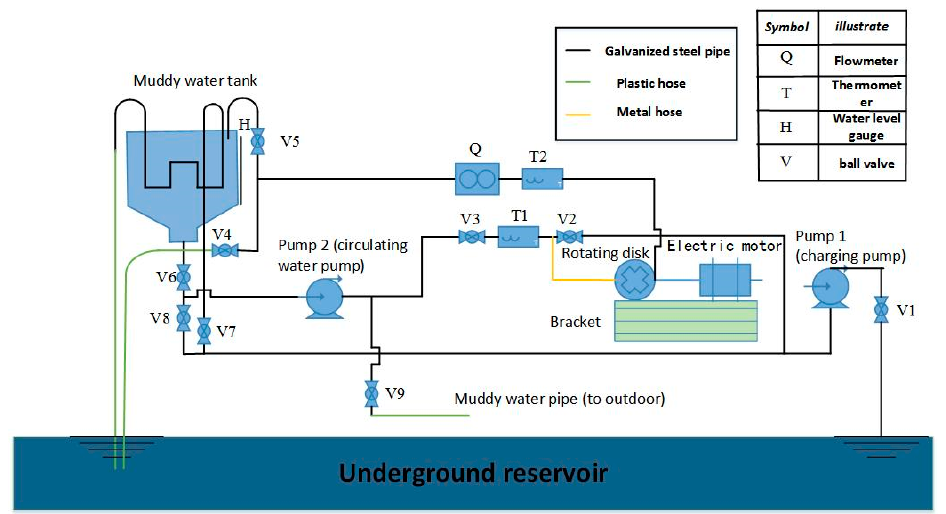
Figure 1. Rotating disc erosion test system.